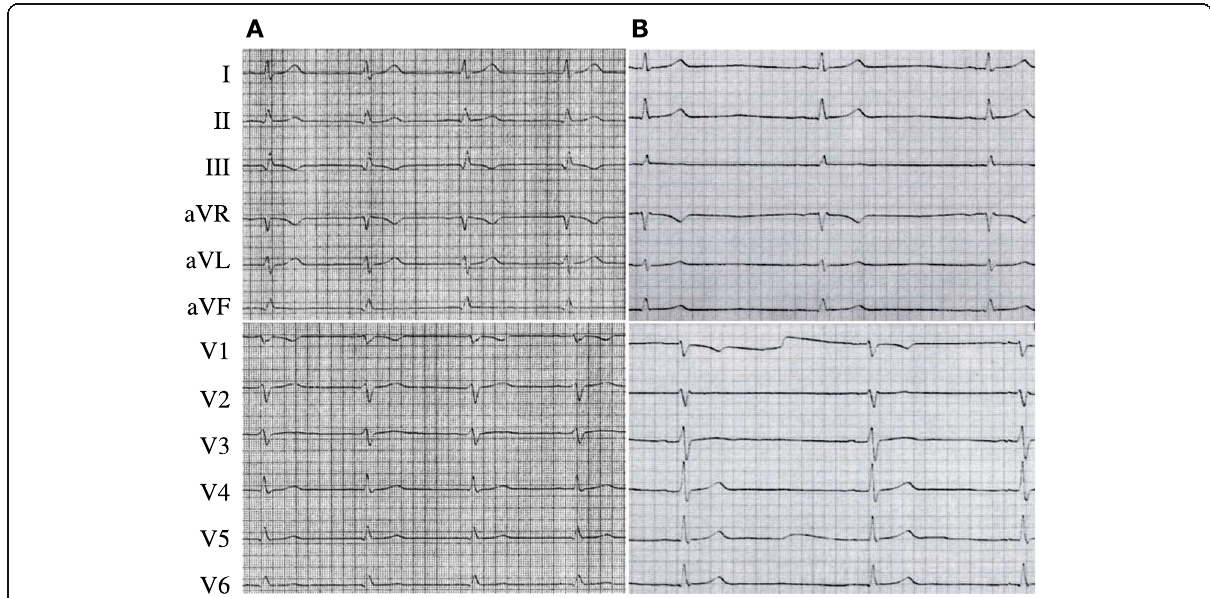
Fig. 2 ECG findings of the patient. a ECG taken 1 year previous to the cardiac event is showing sinus rhythm with a heart rate of 66/min, flat P waves, PR interval 140 ms, QRS 100 ms, T inversion in lead III and QTc of 389 ms. b ECG from approximately 3 months after cardiac event under beta-blocker therapy is showing sinus bradycardia with a heart rate of 38/min, flat P waves, PR interval 190 ms, QRS 110 ms and QTc of 365